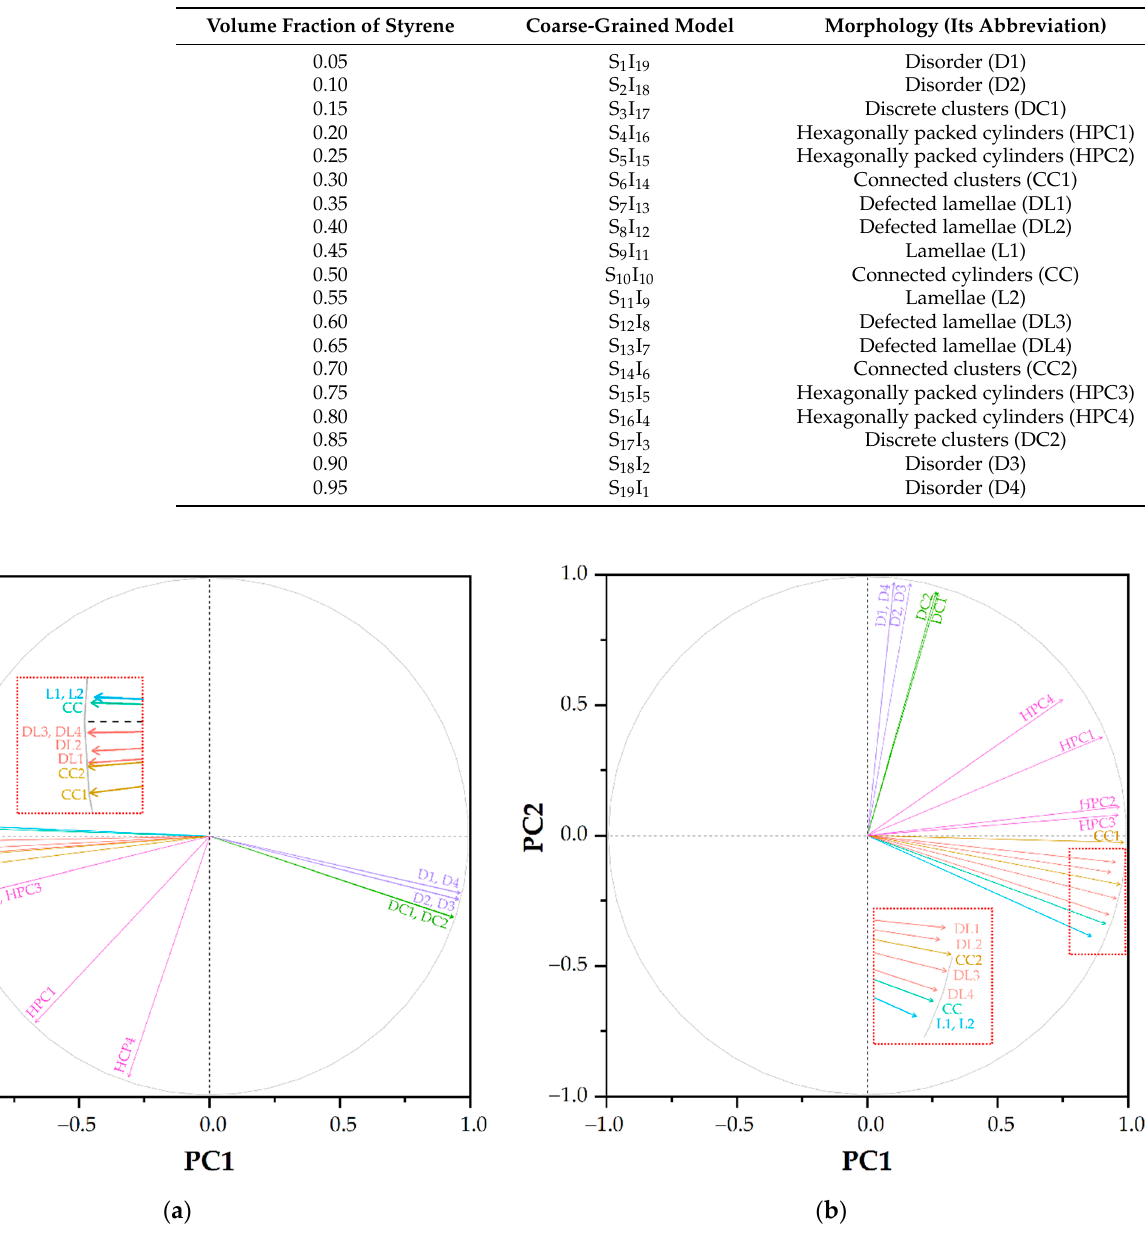
Figure 7. Loading plots of PCA analysis using ( a ) RDFs and ( b ) S( k ) data. The colors violet, green, pink, yellow, red, blue and cyan correspond to disorder, discrete clusters, connected clusters, hexagonally packed cylinders, defected lamellae, lamellae and connected cylinders, respectively. The abbreviations are shown in Table 2.